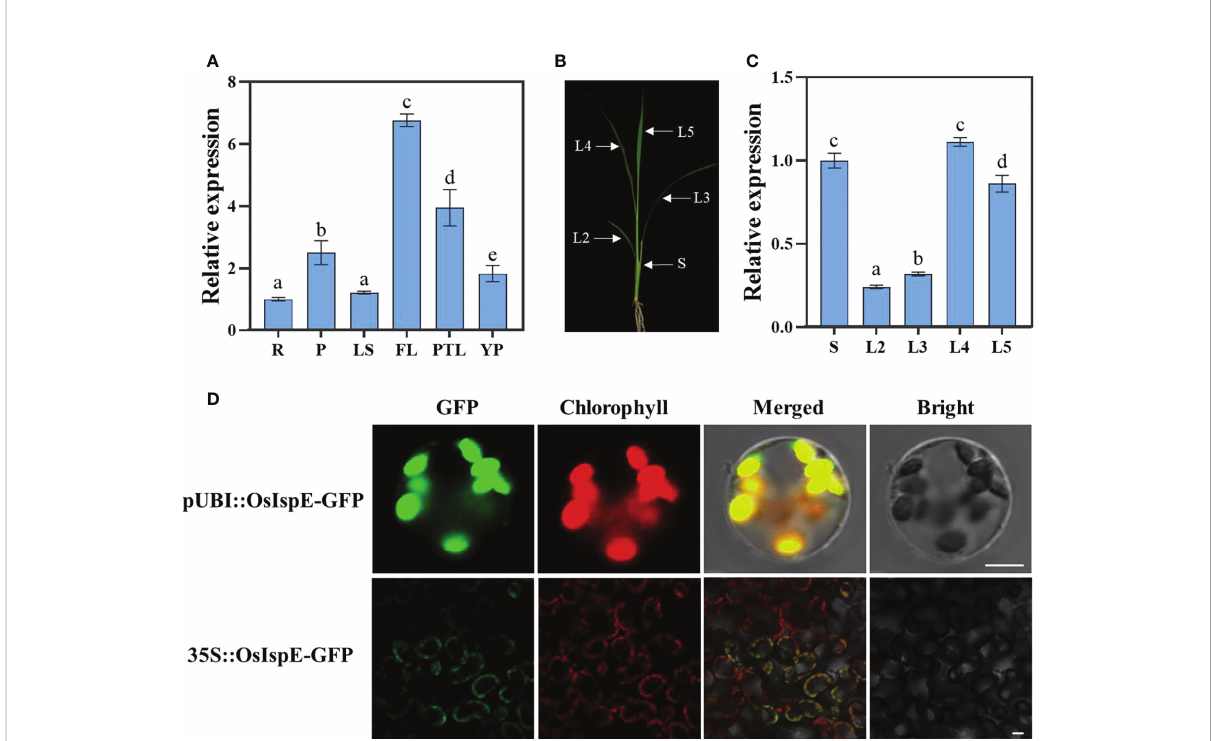
FIGURE 5 Expression pattern and subcellular localization of OsIspE. (A) OsIspE expression levels in different tissues. R, roots; P, pulvinus; LS, leaf sheaths; FL, fl ag leaves; PTL, pour two leaves; YP, young panicles. Values are means ± SD from three biological replicates. (B) Schematic of seedling plant used for RT-qPCR. S represent stem; L2-L5 represent the second to the fi fth leaves. (C) OsIspE expression levels in different tissues of young seedlings. Values are means ± SD from three biological replicates. Data were analyzed using two-way ANOVA with post hoc Tukey tests (letters indicate signi fi cant differences between samples at P < 0.05). (D) Subcellular localization of OsIspE. pUBI::OsIspE-GFP and 35S::OsIspE-GFP were transiently transformed into rice protoplasts and tobacco leaves respectively. Fluorescence signals were detected using confocal microscopy, and representative images are shown. Bars=10 m m (rice protoplast) and 20 m m (tobacco